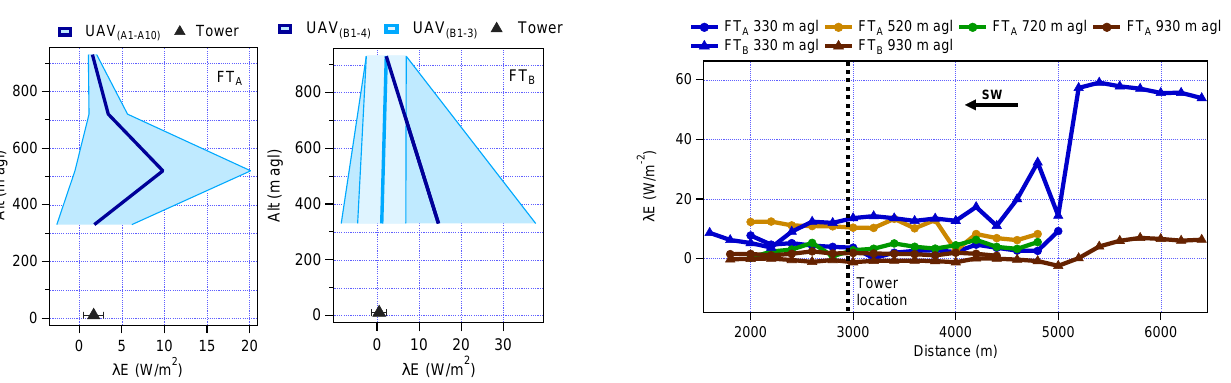
Fig. 12. Mean of λE of flight runs in a SW direction at each altitude for FT A and FT B . North east is towards 0m and the position of the tower along the track is shown. The longer afternoon runs indicate an increase in λE at approximately 5km, hinted at in FT A data, and most likely reflecting the change in surface properties from the surrounding drier desert to the lakebed